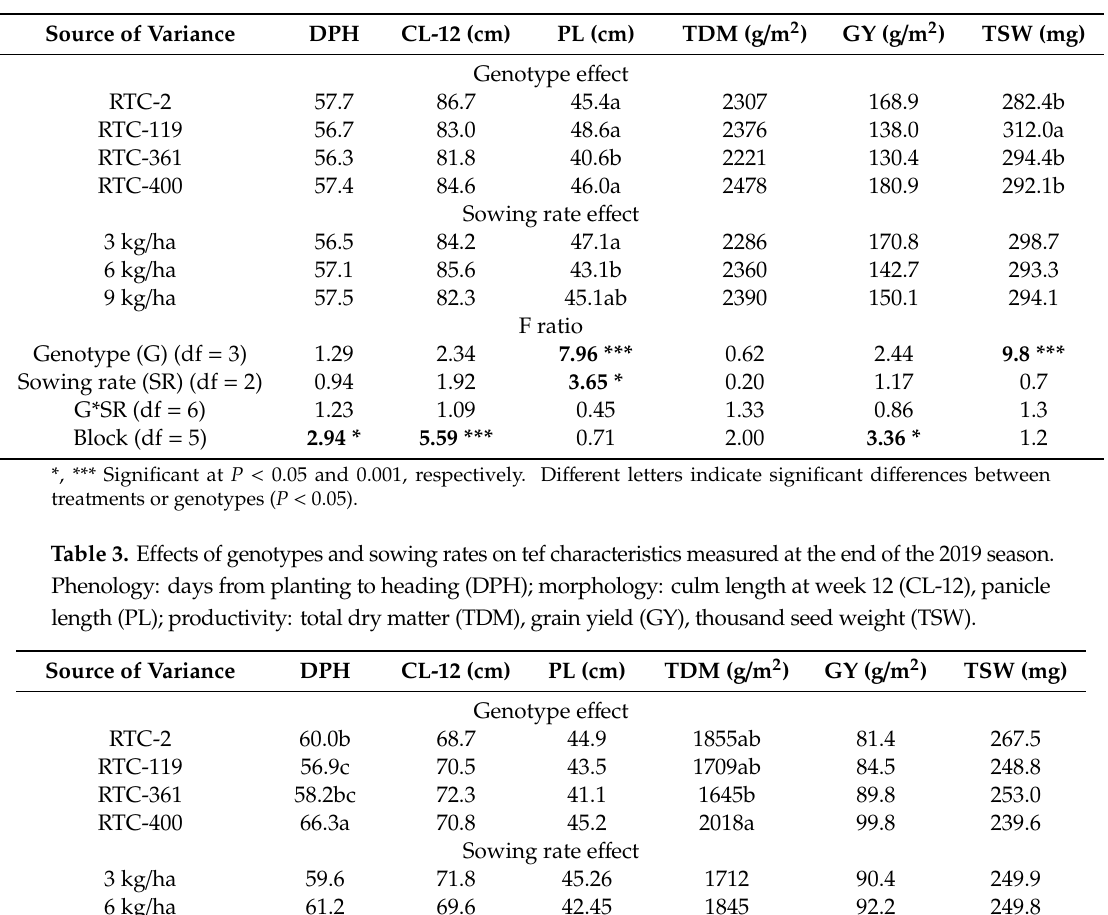
Table 2. Effects of genotypes and sowing rates on tef characteristics measured at the end of the 2018 season. Phenology: days from planting to heading (DPH); morphology: culm length at week 12 (CL-12), panicle length (PL); productivity: total dry matter (TDM), grain yield (GY), thousand seed weight (TSW).